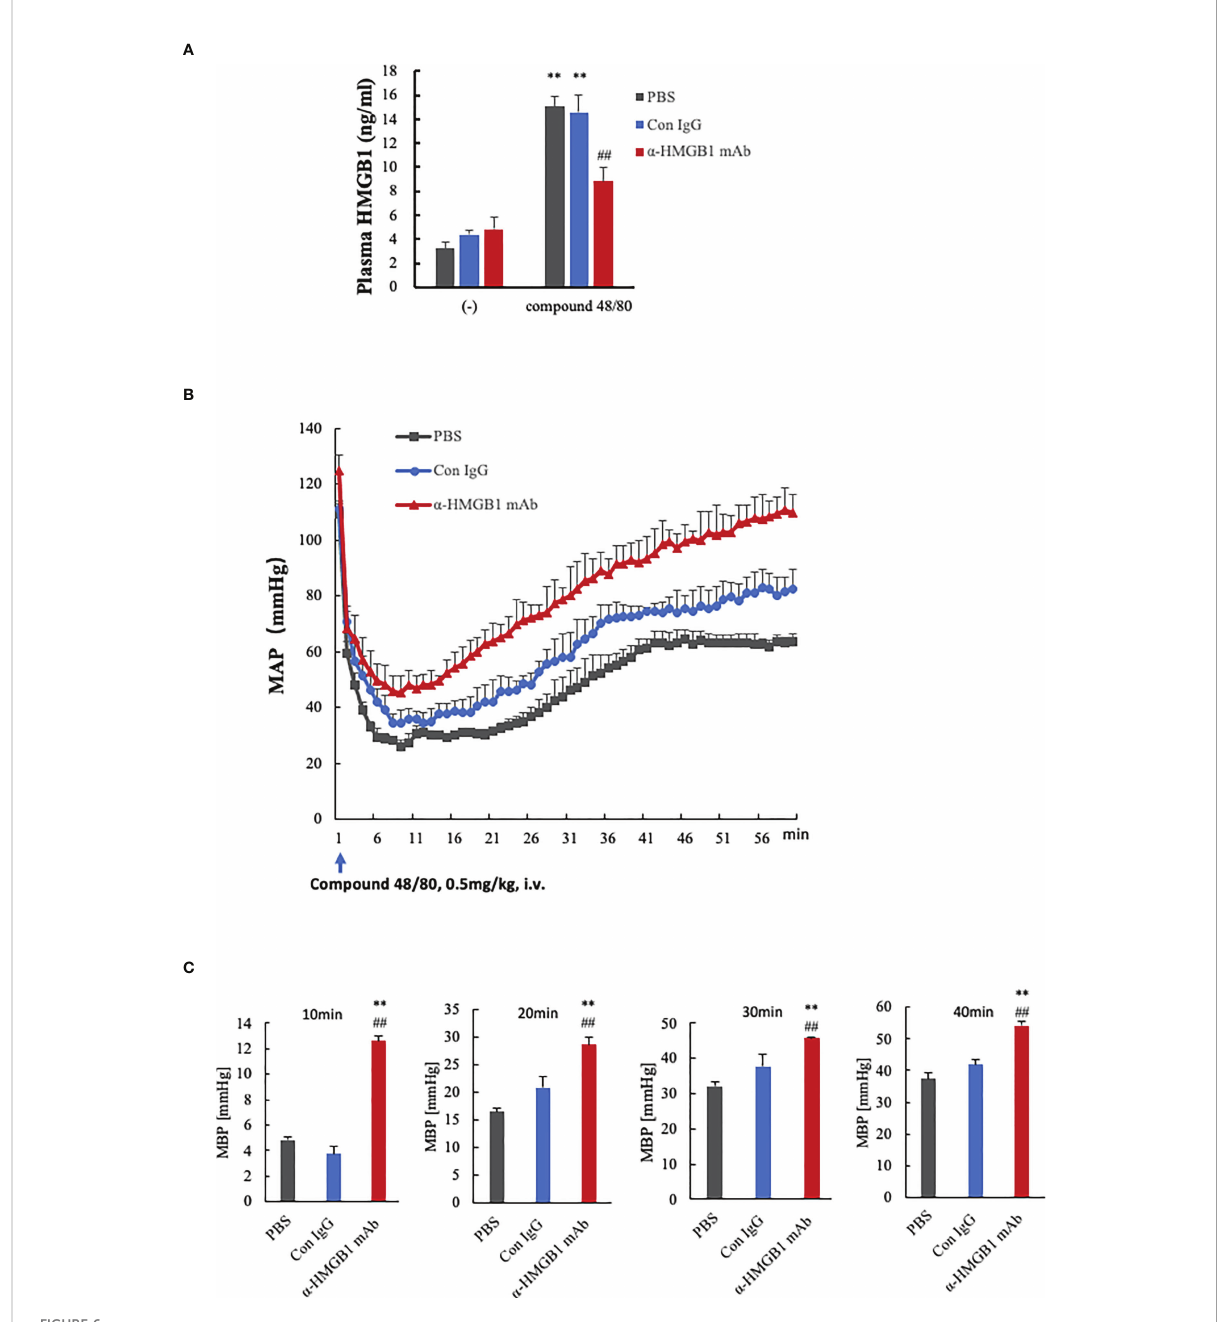
FIGURE 6 Effects of anti-HMGB1 mAb on a compound 48/80-induced rat model of anaphylactic shock. Wistar Rats were given compound 48/80, a mast cell degranulation agent, at a dose of 0.5 mg/kg through the tail vein to induce anaphylactic shock. One minute after compound 48/80 injection, the rats were treated with PBS, anti-KLH mAb (2 mg/kg) or anti-HMGB1 mAb (2 mg/kg) through the tail vein. Measurement of hemodynamic parameters was performed every 5 min for a period of 30 min before the compound 48/80 challenge. The hemodynamic parameters were recorded for 60 min at 1 min intervals after the compound 48/80 challenge. (A) Plasma levels of HMGB1 in rats at 10 min after compound 48/80 injection were determined by ELISA. (B) Records of mean arterial blood pressure (MAP, mmHg) of rats treated with PBS, control mAb or anti-HMGB1Ab. MAP was recorded every minute until the end of the experiment at 60 min. Each point represents the means ± SEM of six rats, (n=6 per group). All results are the mean±SEM of fi ve different experiments. One-way ANOVA followed by the post hoc Fisher test. **p<0.05 vs. PBS, ## p<0.05 vs. Control IgG. (C) The absolute increase in the value of MBP from the lowest after AS induction to the indicted time was quanti fi ed in each group. one-way ANOVA followed by the post hoc Fisher test. **p<0.05 vs. control, ## p<0.05 vs. Con